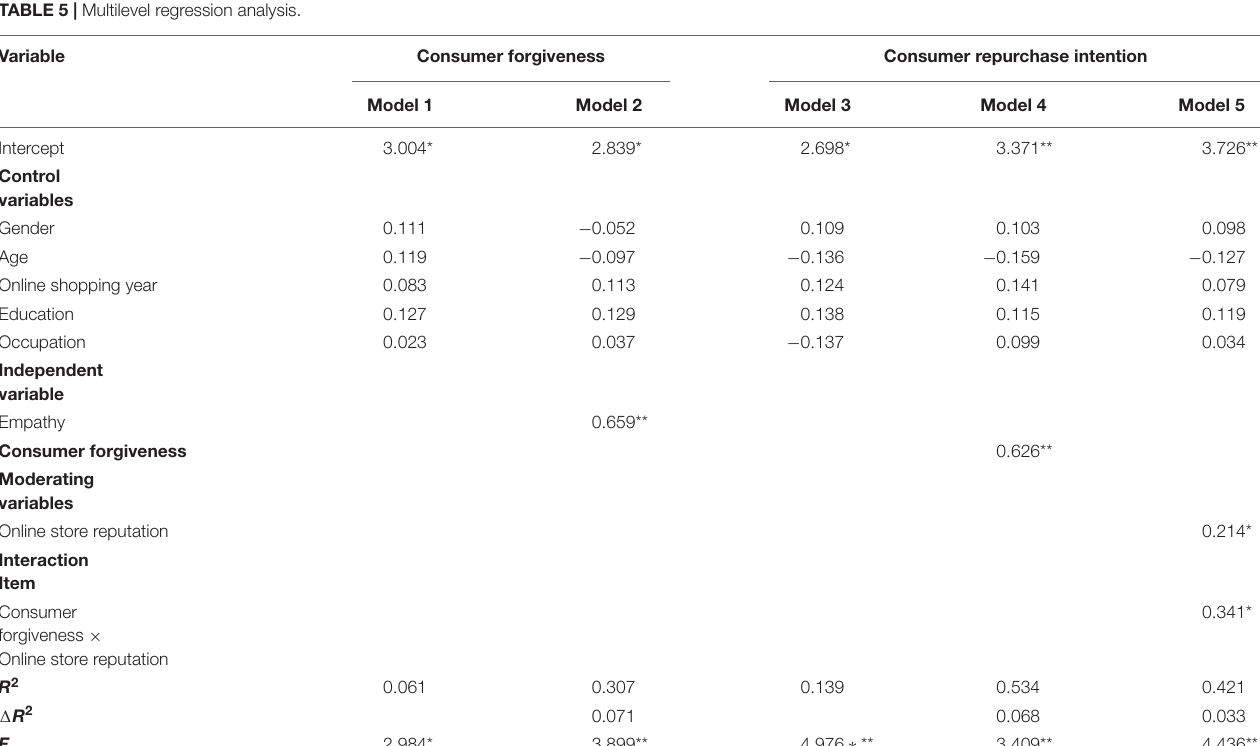
TABLE 5 | Multilevel regression